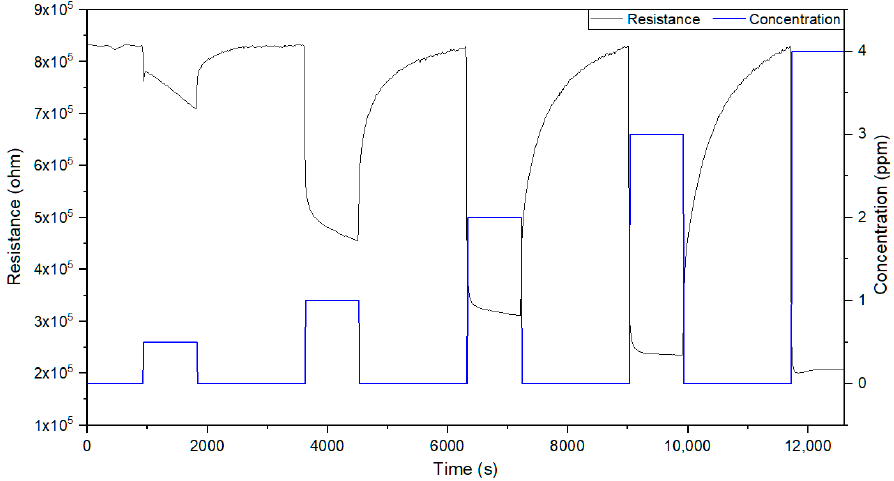
Figure 5. Resistance curve to different concentrations of acetone (0.5, 1, 2, 3 and 4 ppm) in dry air (0% RH) at 300 °C.